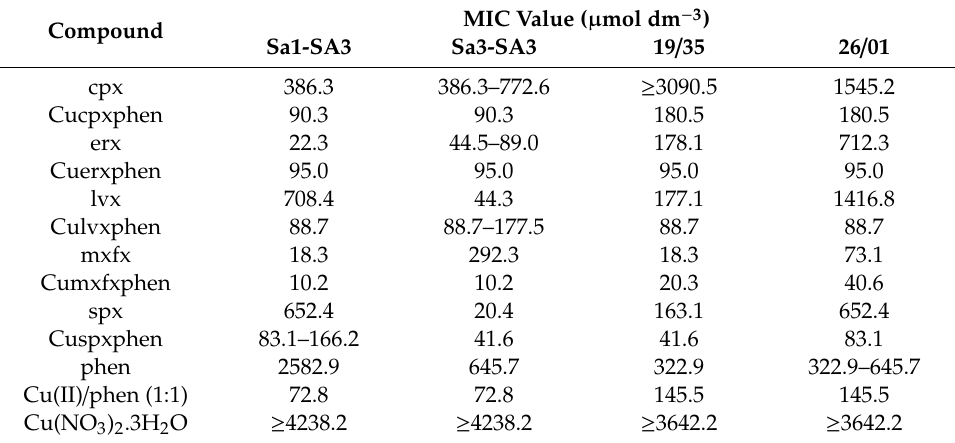
Table 3. MIC values of several FQs, CuFQphen complexes, phen, Cu(II) / phen (1:1) and Cu(NO 3 ) 2 .3H 2 O salt against four MRSA isolates (Sa1-SA3, Sa3-SA3, 19 / 35 and 26 / 01). Values presented were obtained from at least three independent